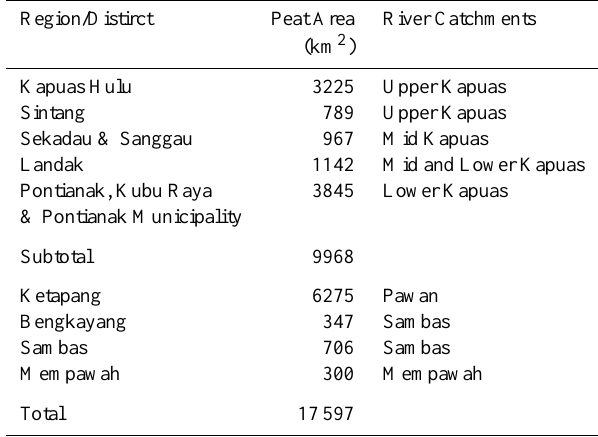
Table 1. Peat Distribution and Associated Peatland Draining Rivers in West Kalimantan Province (Source: Modified from BPS Kali- mantan Barat,